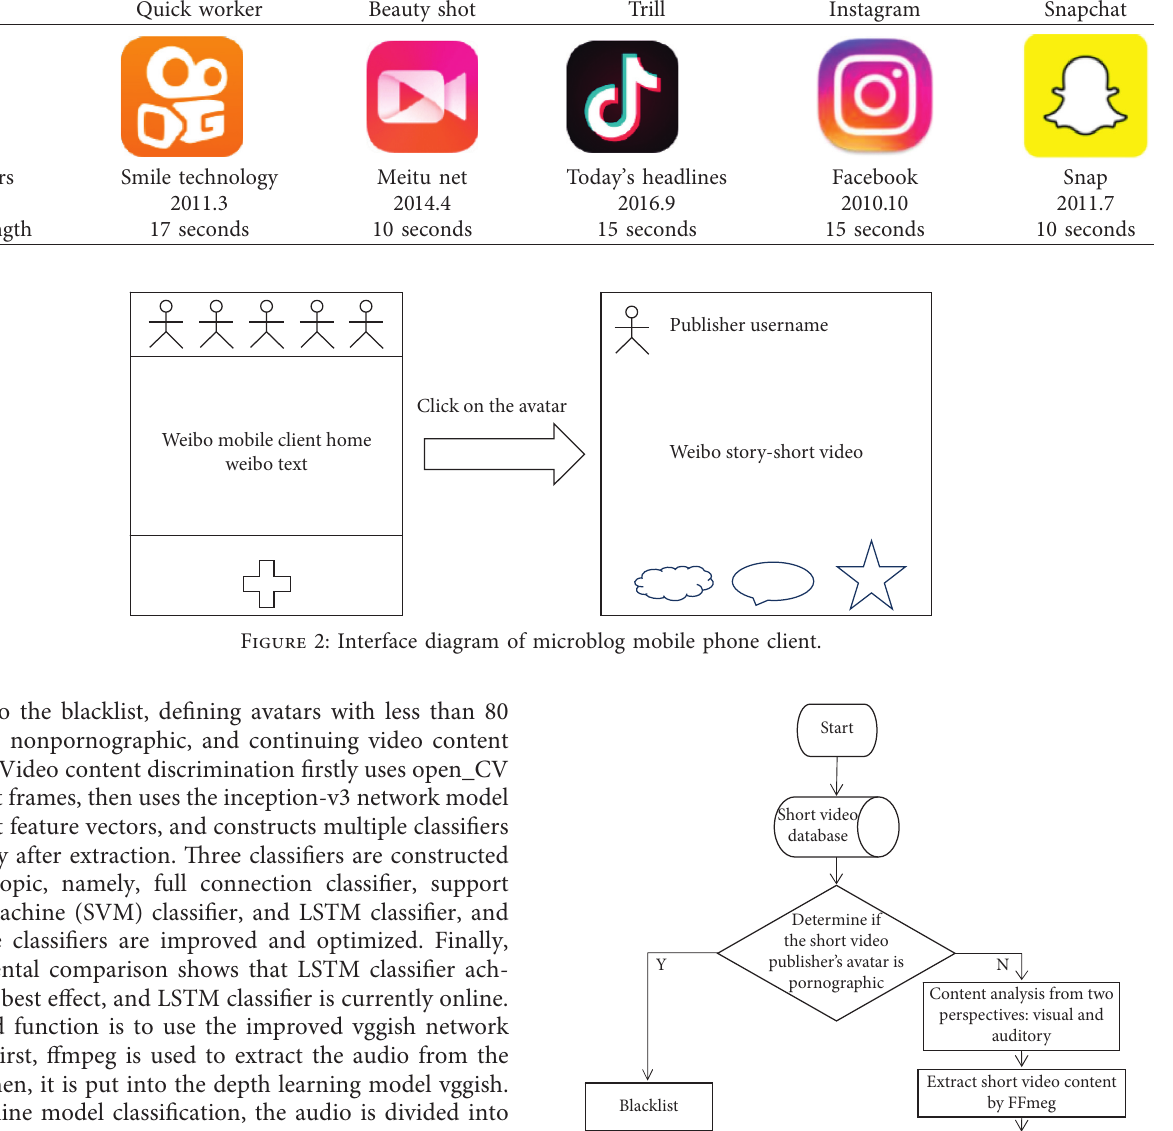
Table 1: Analysis of present situation of typical social short video app at home and abroad. Type